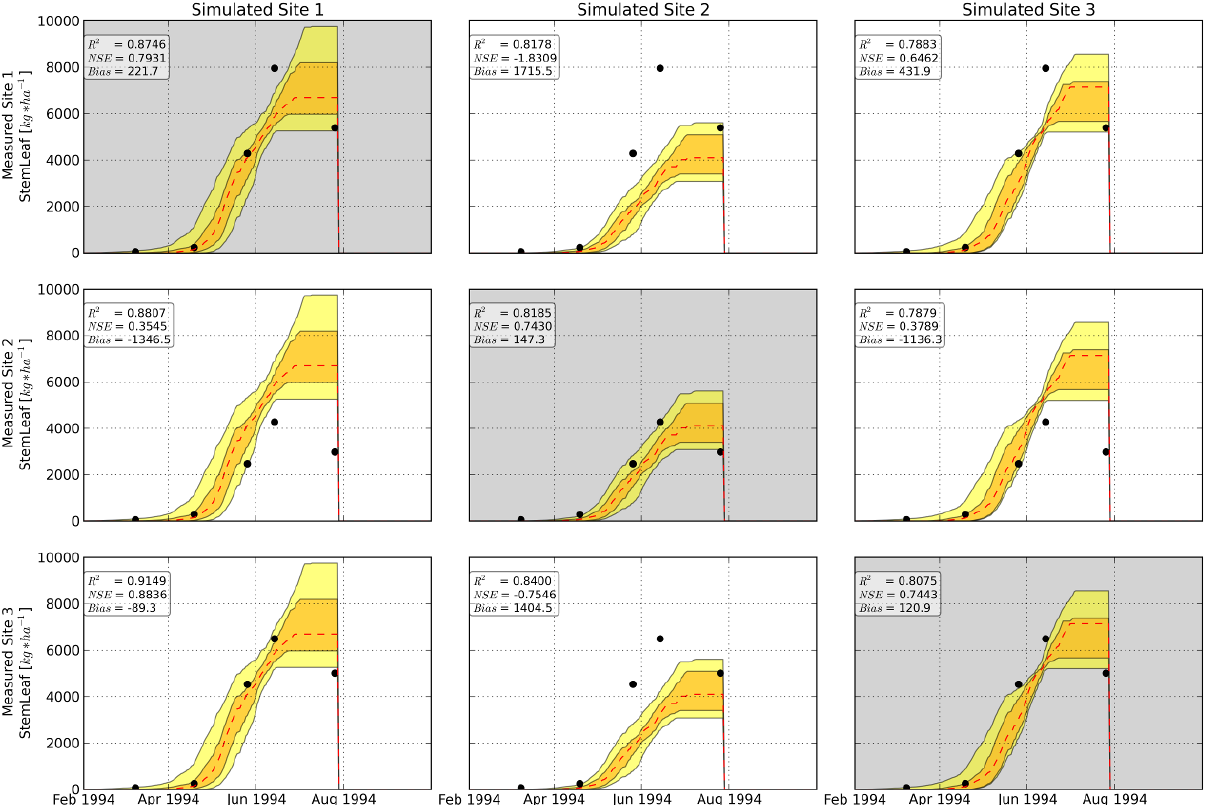
Fig. 6. Cross validation of stem and leaves prediction with uncertainty boundaries. Grey-shaded sites are calibrated. Black dots are observed values, and the red dashed line is the median of the behavioural boundary condition (NSE > 0, bias < ± 500kgha − 1 plant dry matter and R 2 > 0 . 3). The yellow area is the 95% probability range of the simulation, and the orange area the 50% probability range. Figure 6. Cross-validation of stem and leaves prediction with uncertainty boundaries. Grey 3 level of 0.48 for site 1 to NSE = 0 . 31 for site 2 and an NSE shaded sites are calibrated. Black dots are observed values, red dashed line is the median of 4 of 0.37 for site 3. The same cross validation at the other sites the behavioural boundary condition (NSE>0, bias<±500 kg ha -1 plant dry matter and R²>0.3). 5 resulted in a small but constant range of NSE between 0.23 The yellow area is the 95% probability range of the simulation, the orange area the 50% 6 between very low soil moisture of − 0.6 and − 1.0 probability range. 7